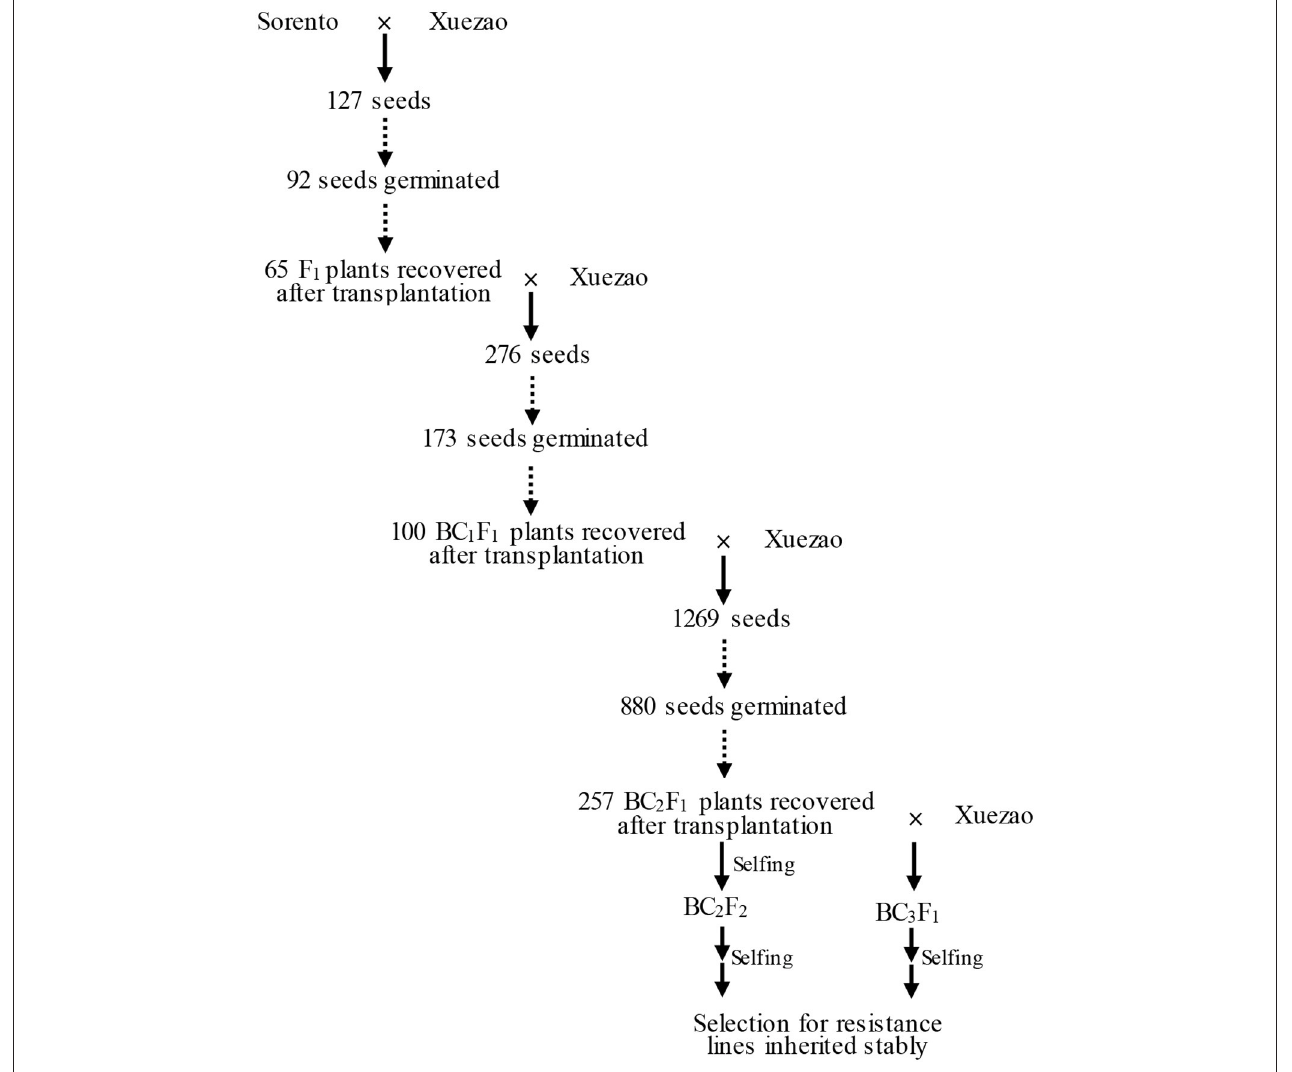
FIGURE 1 | Procedure for transferring resistance from Sorento into